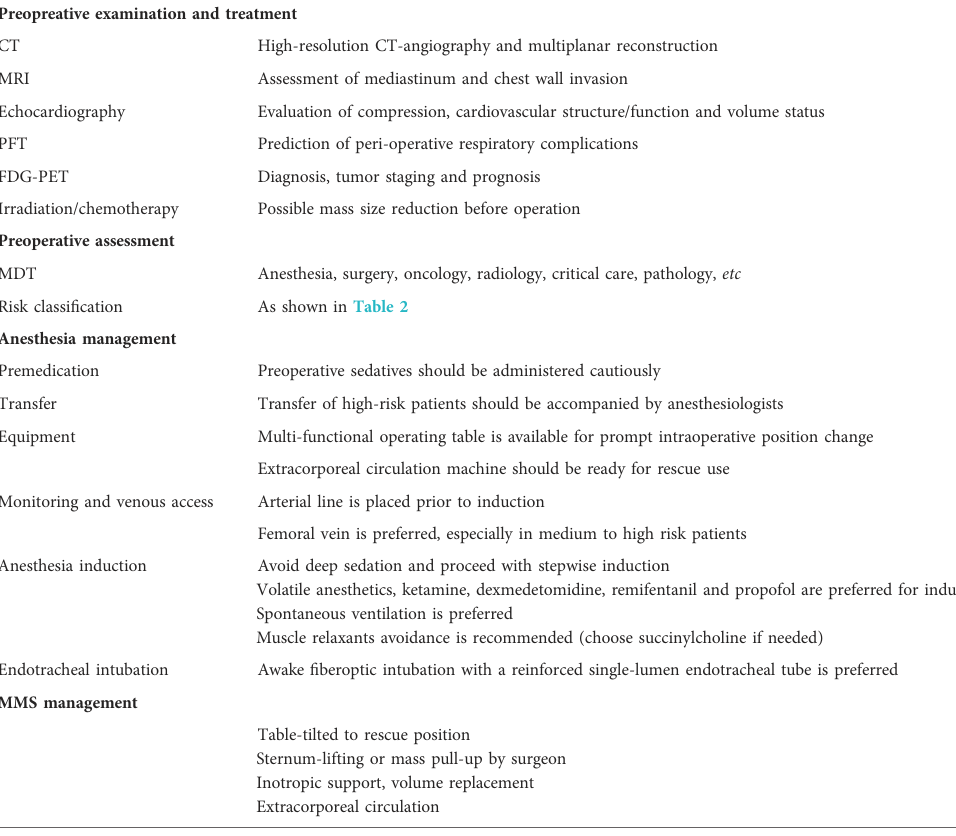
Table-tilted to rescue position Sternum-lifting or mass pull-up by